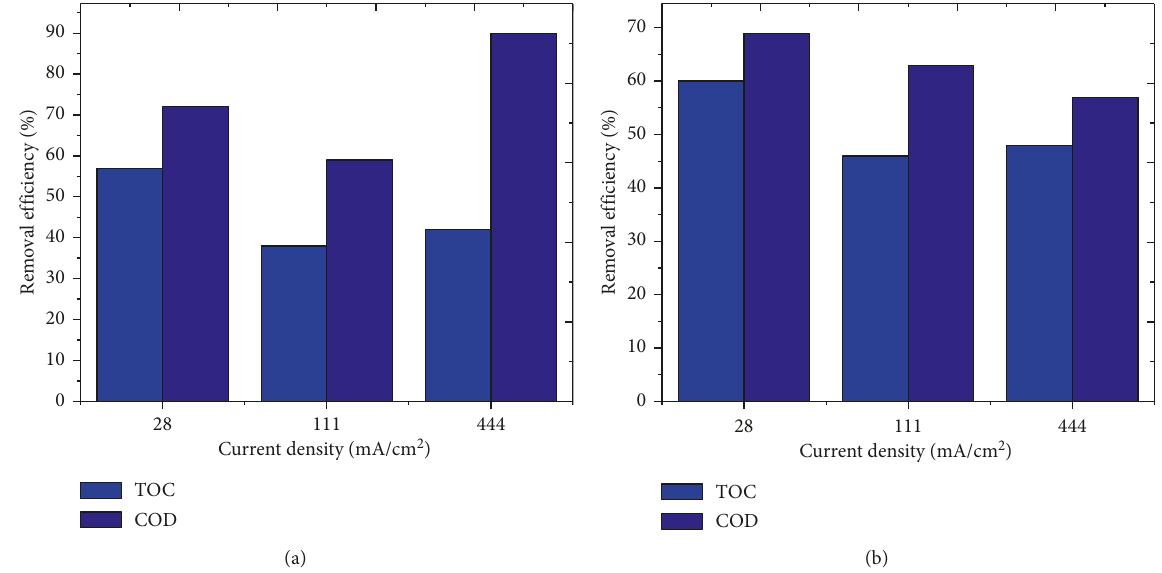
Figure 2: Removal efficiency of TOC and COD after 60min of EC process using (a) Fe and (b) Al electrodes at different current densities (444, 111, and 28mA/cm 2 ) for 1.0L of S1 wastewater.